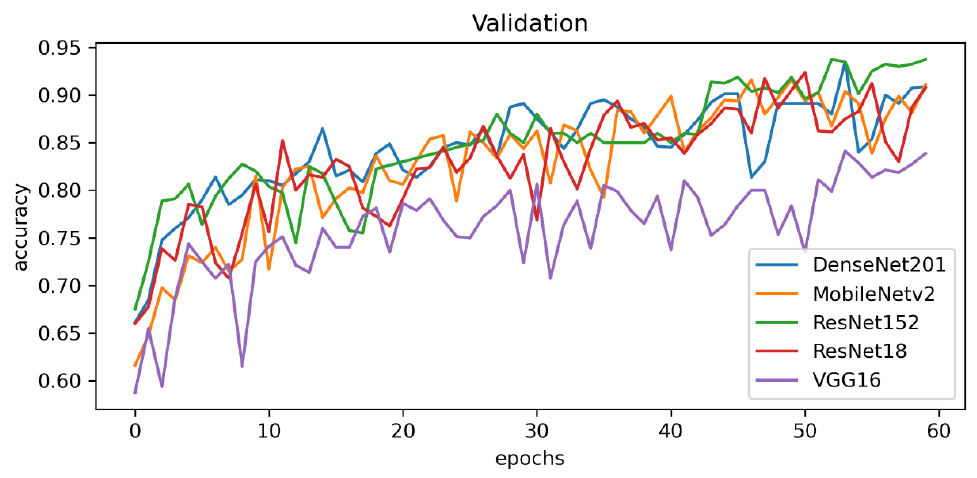
Figure 5. Validation accuracy of the CNN models for the backbone of explainable AI.